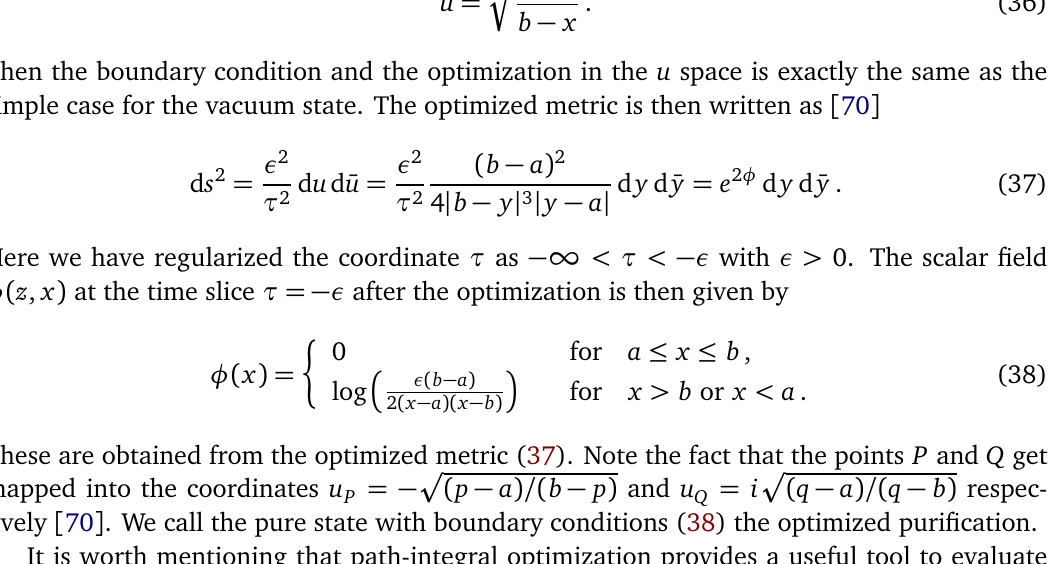
, P , K and Q are a , p , b , q . The PEE is given 1 2 (shown by the blue AB